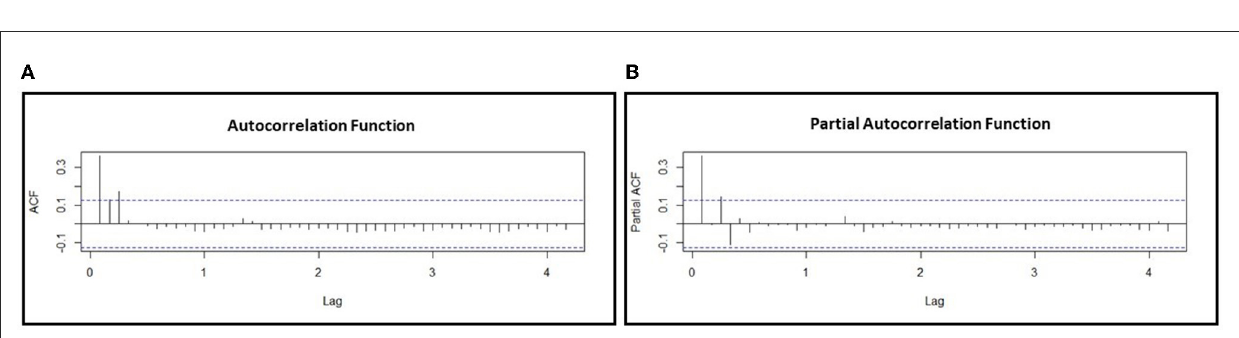
FIGURE5 The chart of (A) auto-correlation function (ACF) and (B) partial auto-correlation function (PACF) for determining the order of GARCH model.